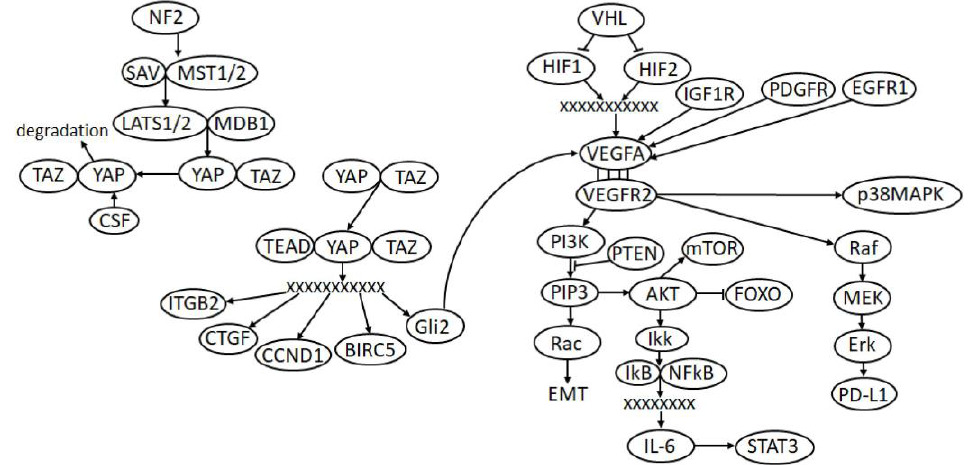
Figure 1. Some signaling pathways and their relationships (VHL/VEGF/HIF, PI3K/AKT, Hippo, etc.) in ccRCC. Proteins are within the ovals; straight arrows indicate activating interactions; blunt arrows indicate inhibitory interaction; the crosses indicate the interaction of transcription factors and their complexes with the regulatory regions of genes; 4 parallel small dashes show the interaction between the receptor and the ligand (VEGFA).